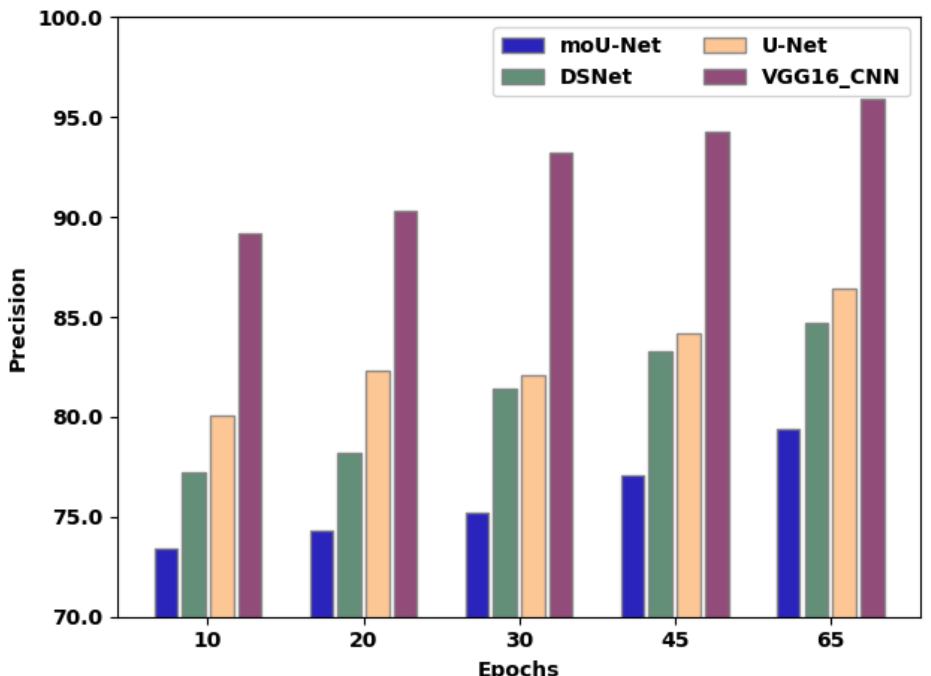
Figure 9. Precision correlation of the existing techniques and proposed method.